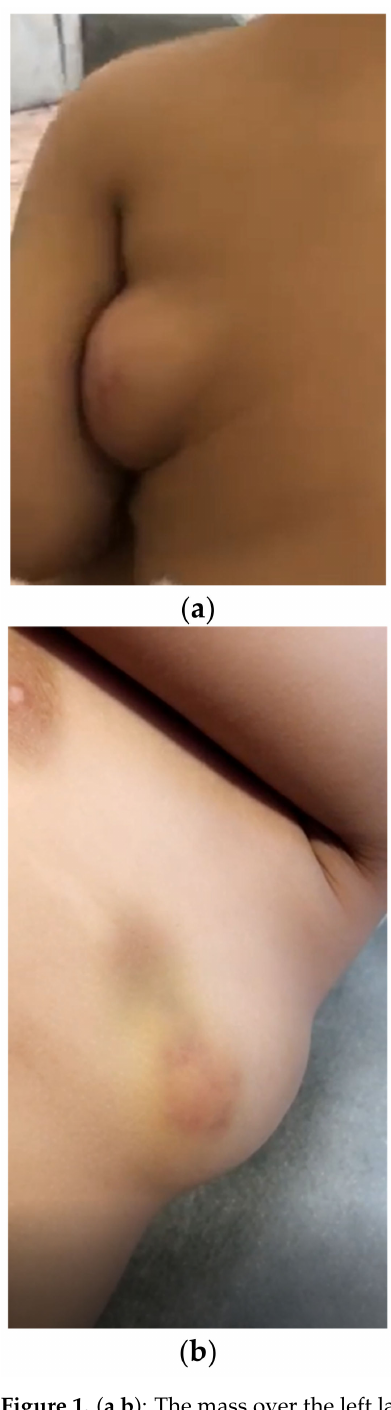
Figure 1. ( a , b ): The mass over the left lateral chest ( a ) posterior and ( b ) anterior images. Basic laboratory investigations, including a complete blood count with a differential count, were normal. Chest radiography revealed a mass-like opacity in the left lateral chest wall (Figure 2). An ultrasound scan (USS) of the chest wall detected multiple, well- circumscribed, anechoic subcutaneous cystic lesions of variable size, the largest measuring 2.1 × 0.7 cm (Figure 3). Colour Doppler USS showed no vascularity within the